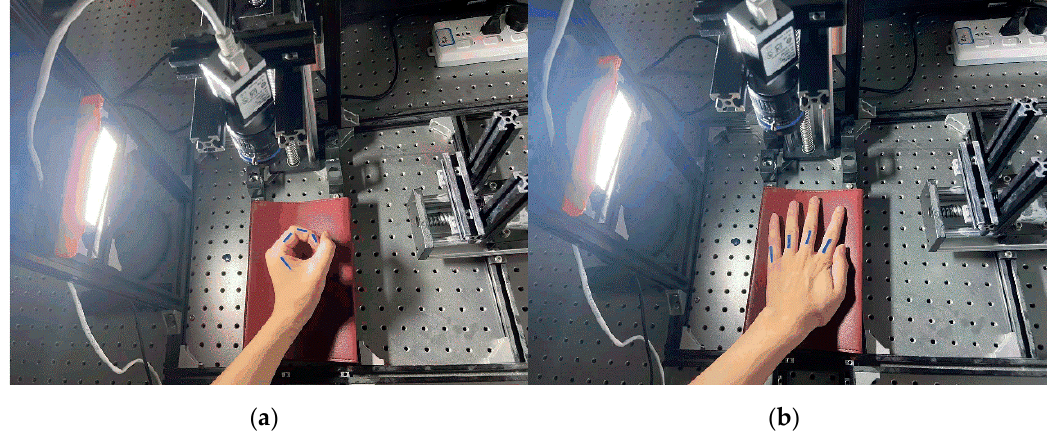
Figure 3. Finger-joint-angle-detection